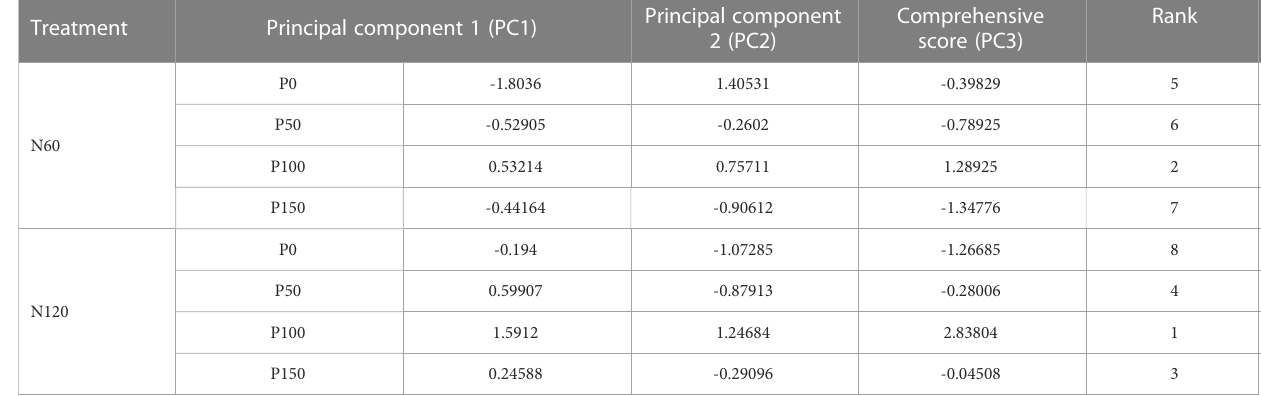
TABLE 2 Principal components, comprehensive scores and rankings under nitrogen and phosphorus combined